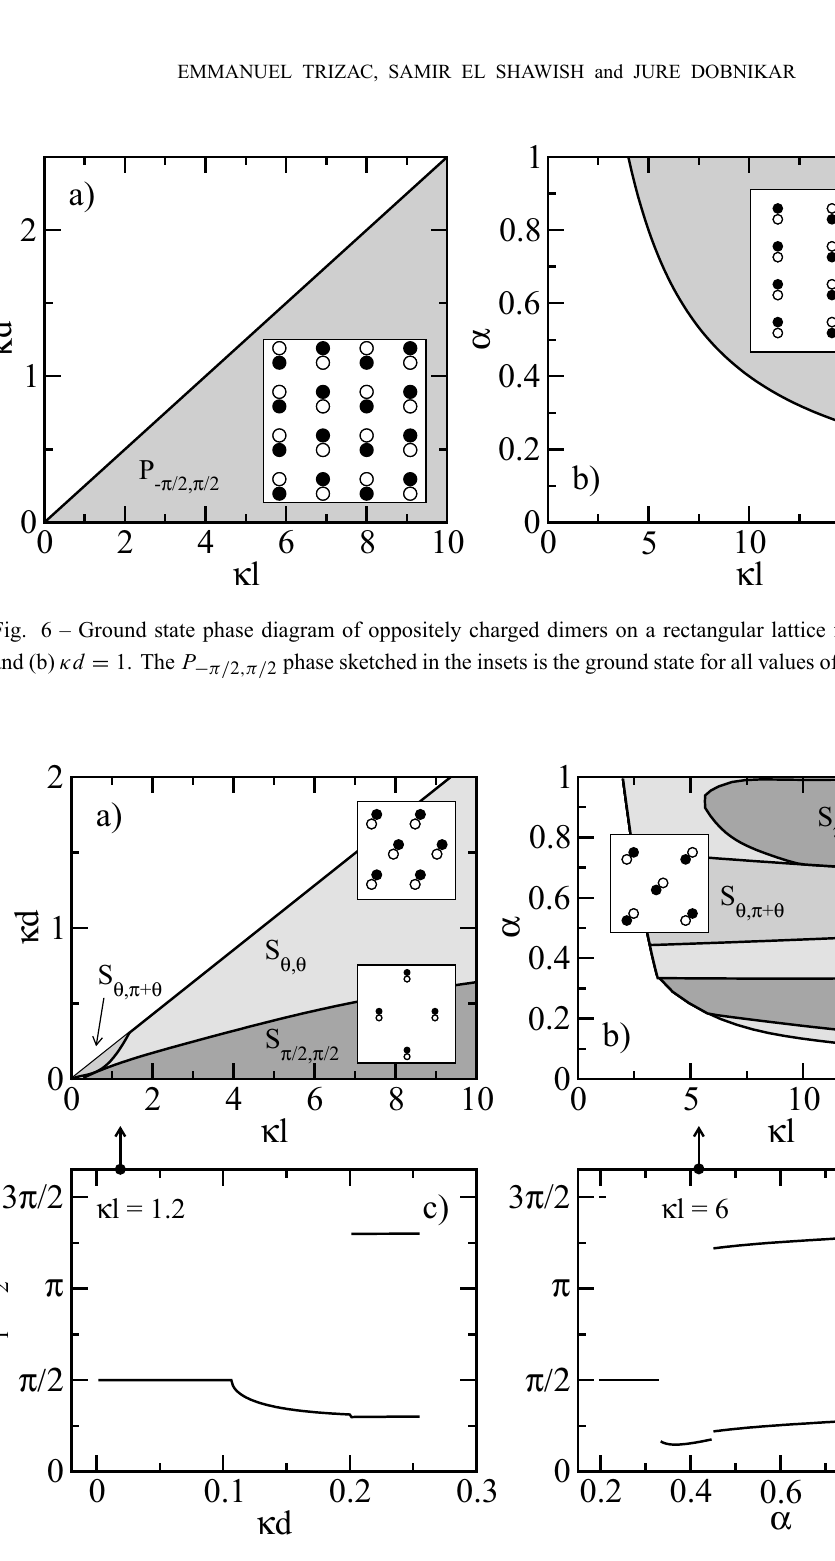
An Acad Bras Cienc (2010) 82